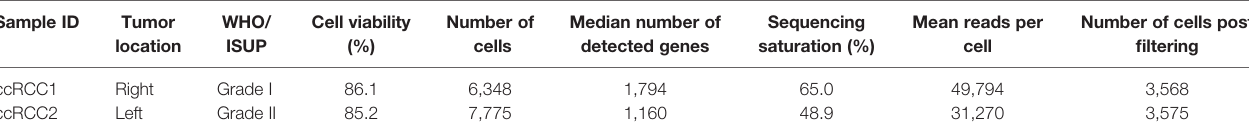
TABLE 2 | Information and sequencing statistics of bilateral renal cell carcinoma samples.